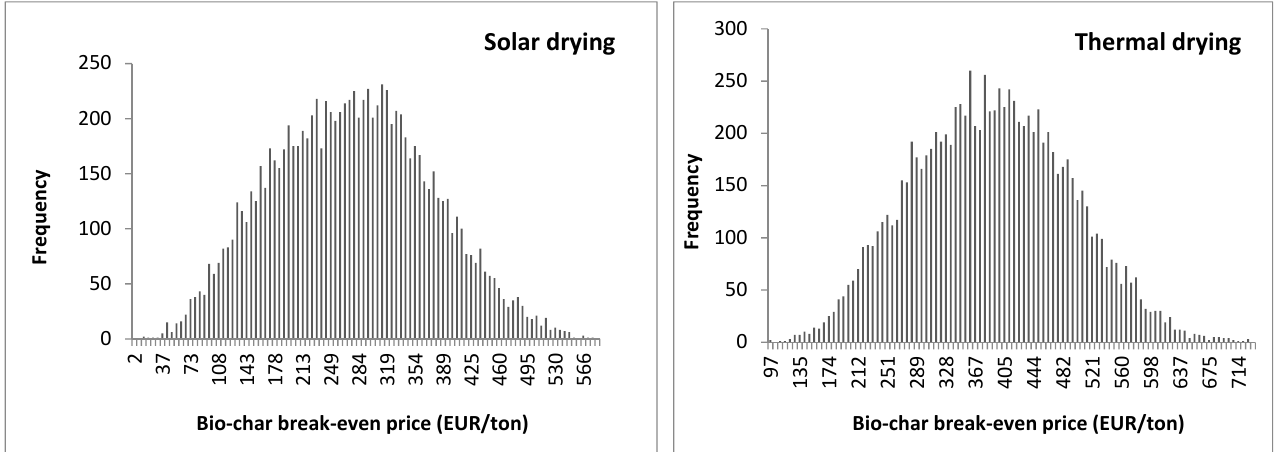
Figure 5. Results of Monte Carlo simulation for solar drying ( left ) and thermal drying ( right ) con- Figure 5. ResultsofMonteCarlosimulationforsolardrying( left )andthermaldrying( right figuration.